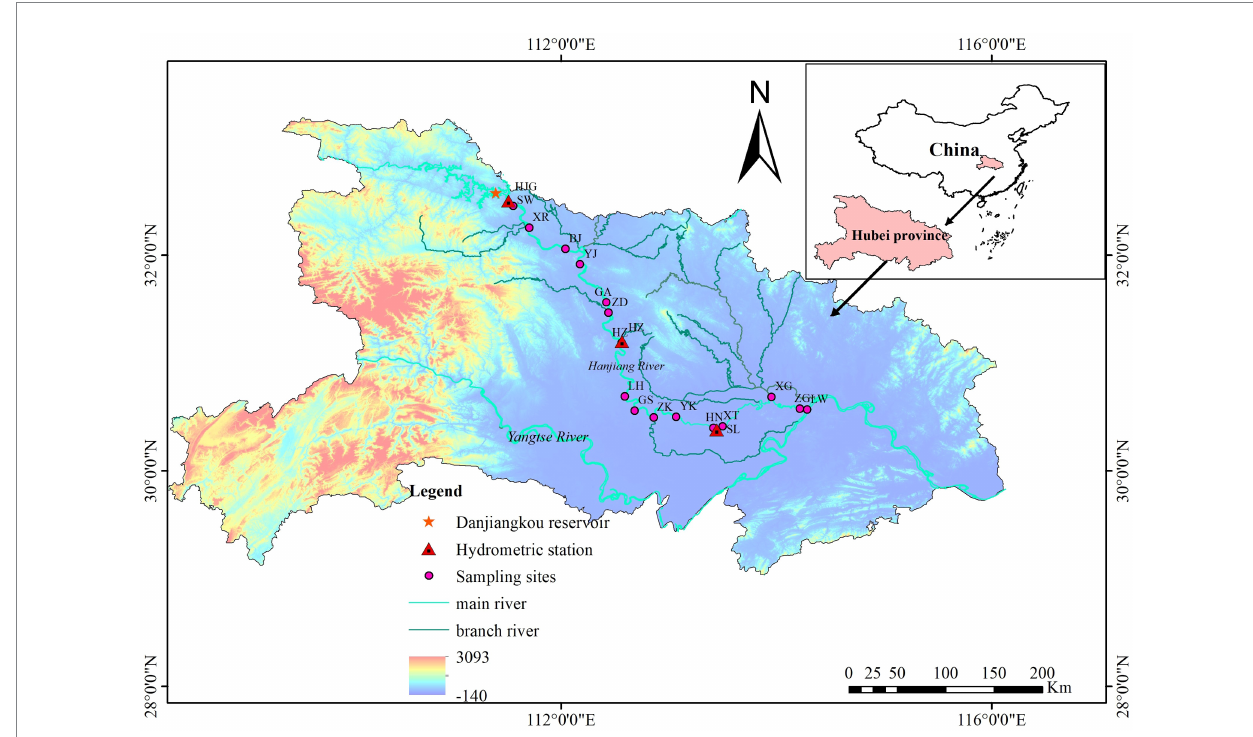
FIGURE 1 Locations of water quality sampling sites and hydrometeorological monitoring stations in this